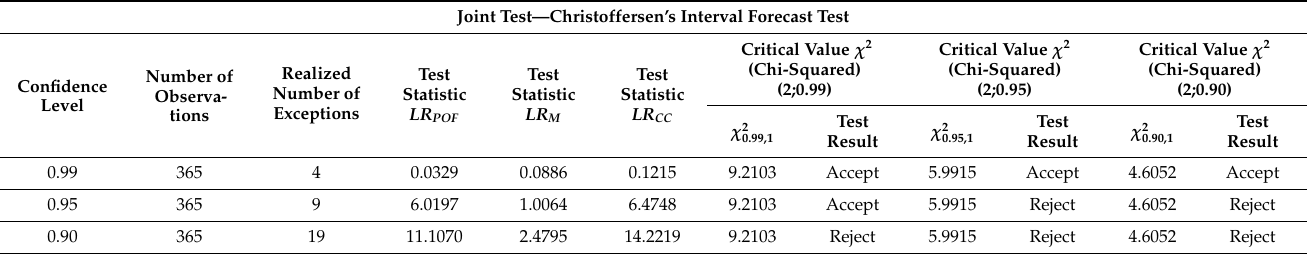
Table 9. Christoffersen’s Interval Forecast test on Delta-Normal VaR. Joint Test—Christoffersen’s Interval Forecast